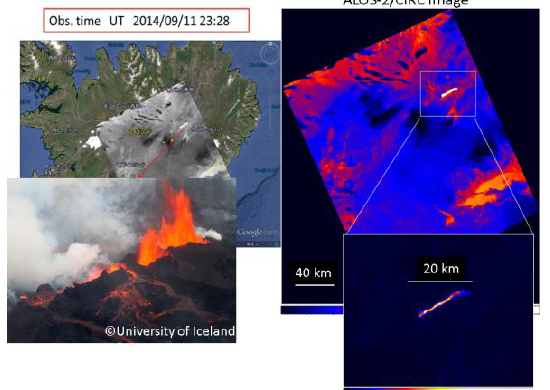
Figure 14. Bardarbunga volcano in Iceland (UTC 23:28, September 11, 2014).